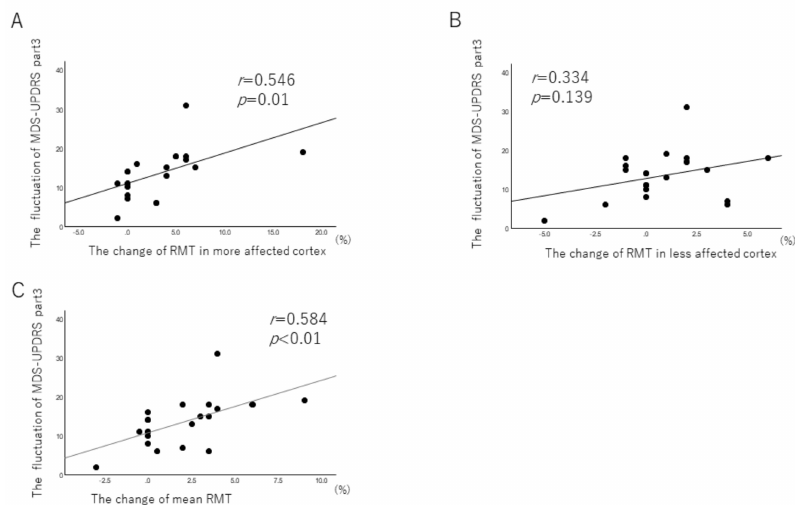
Figure 3. The relationship between the change in RMT and the motor fluctuation between ON and OFF in Parkinson’s disease. ( A – C ): ( A ), more affected cortex, ( B ), less affected cortex, ( C ) mean